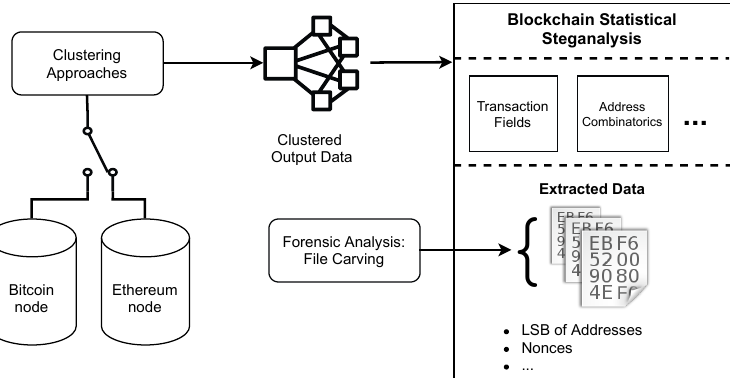
Figure 2. Steganalysis approach proposed for blockchains, instantiated with Bitcoin and